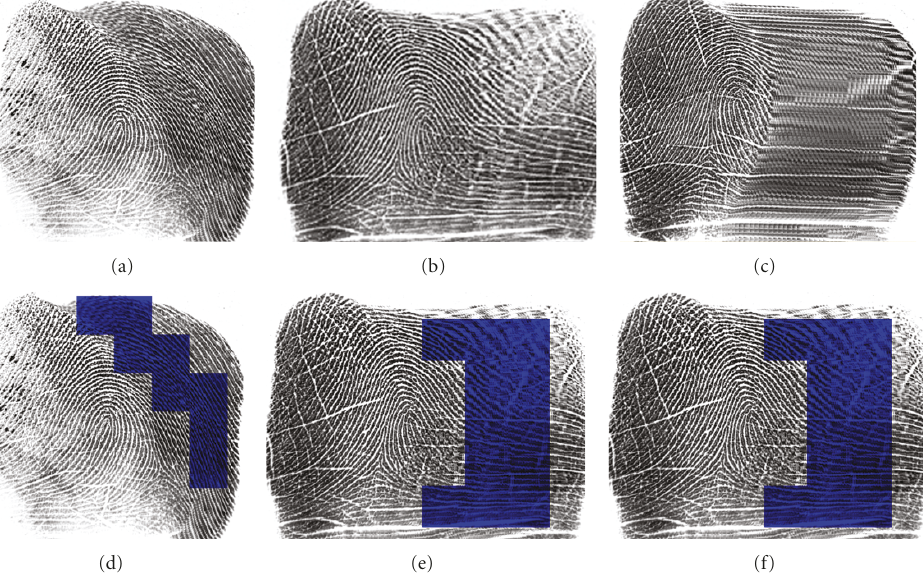
Figure 11: SWT-GLCM-based smear detection results.